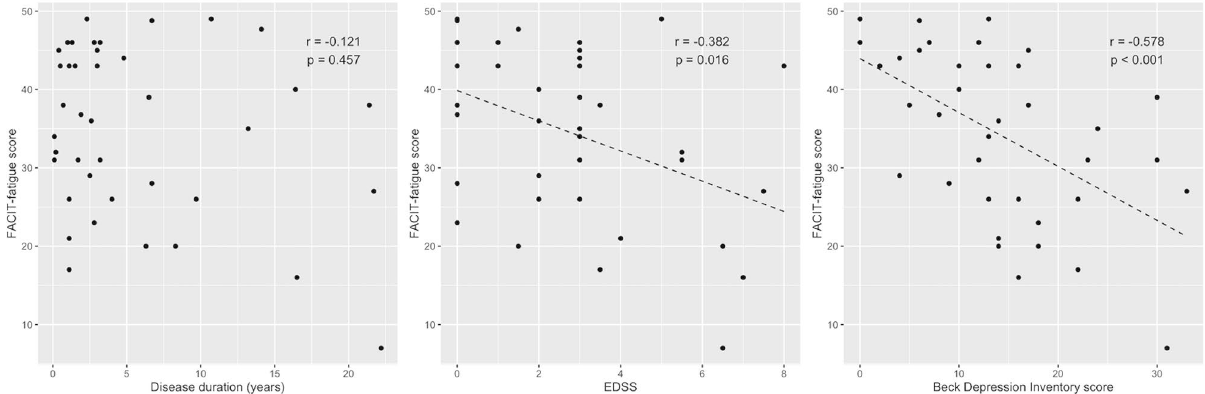
Figure 1. Scatter plots depicting correlation among disease duration, EDSS, BDI, and FACIT-fatigue. The FACIT-fatigue score was negatively correlated with EDSS and BDI scores; however, no correlation was observed between the FACIT-fatigue score and disease duration.